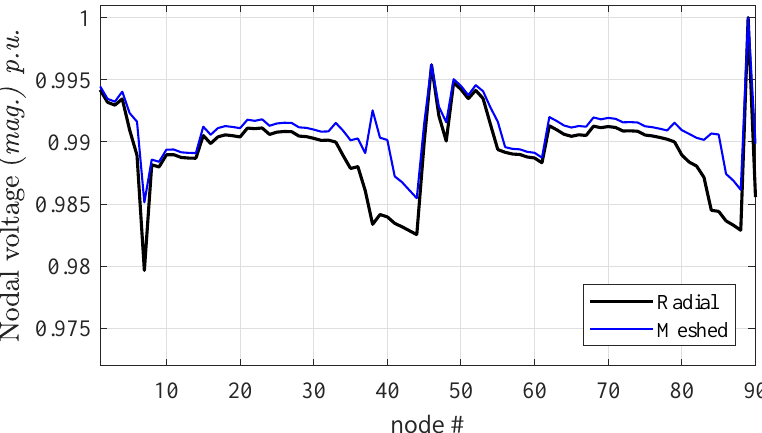
Figure 7. Voltage profile of the Test90 network; differences between radial and weakly meshed